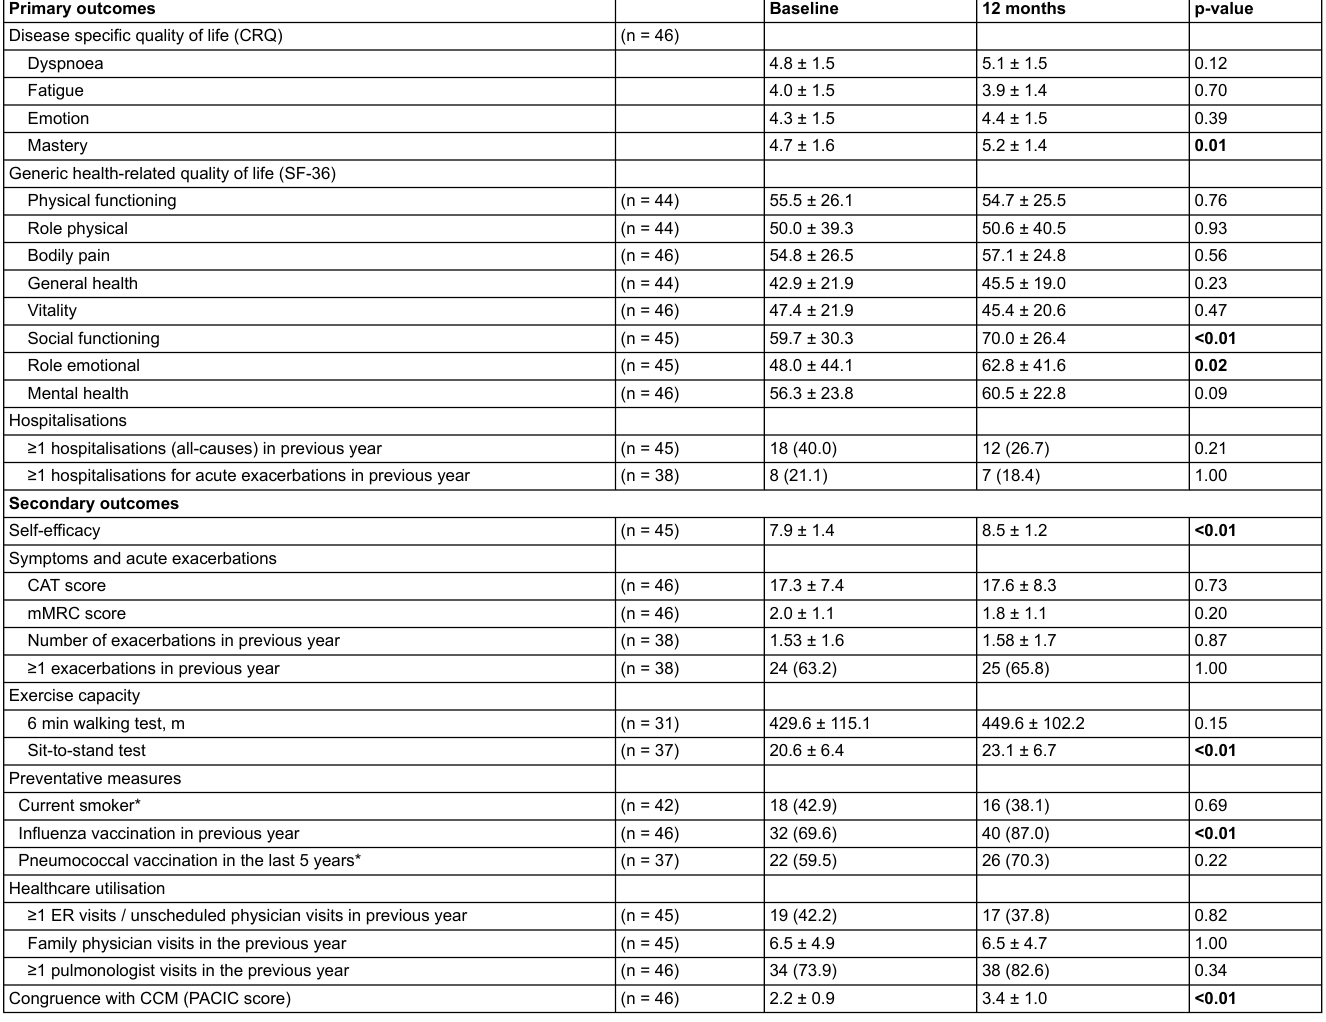
Table 3: Primary and secondary outcomes.